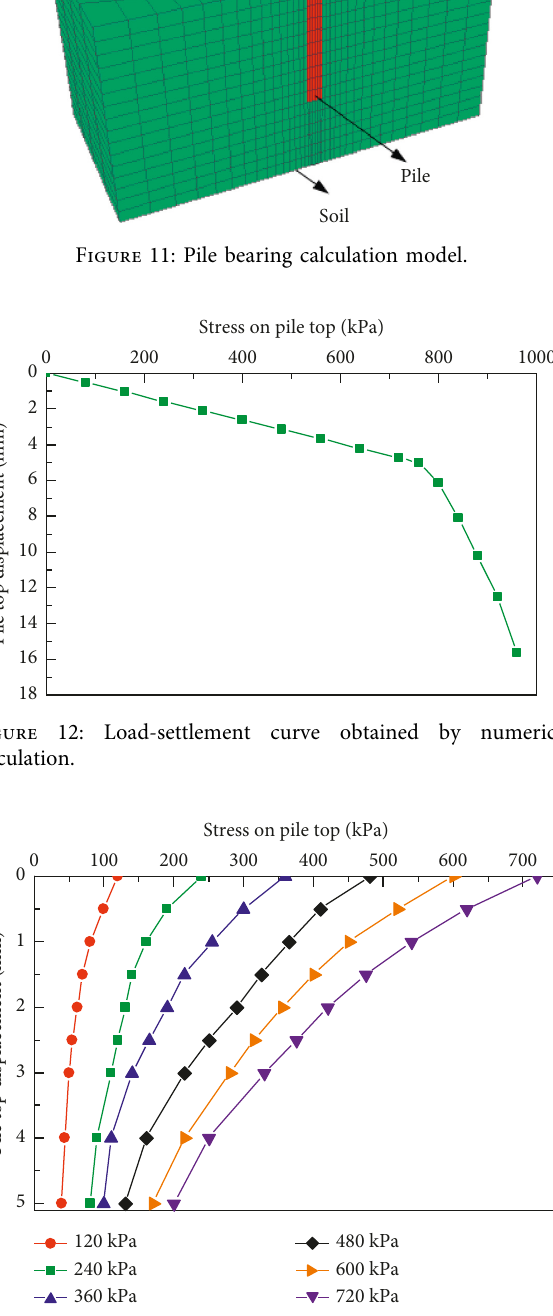
Figure 13: Axial stress curve of pile body under different pile top